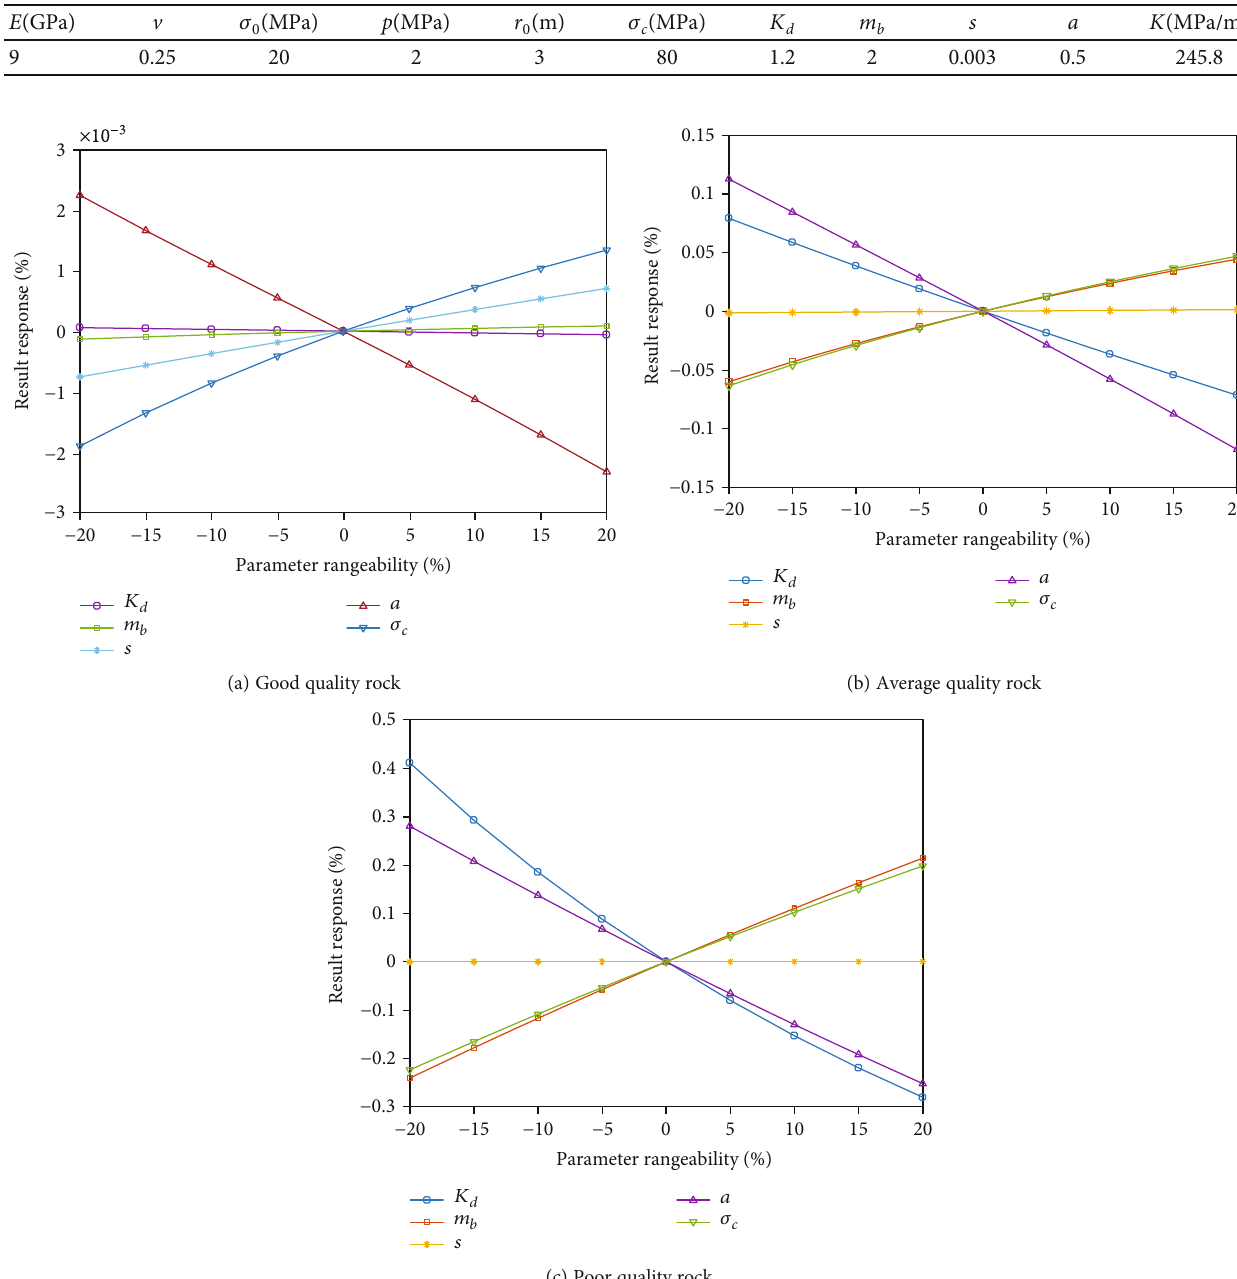
Figure 2: Sensitivity of mechanical parameters on rock resistant coe ffi